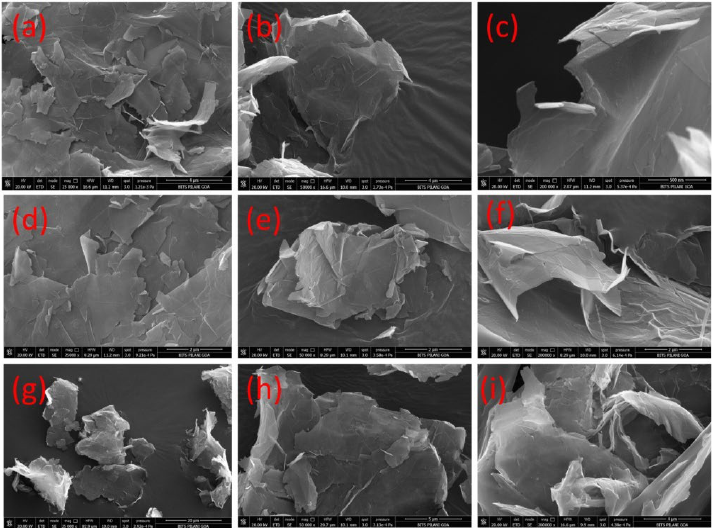
Figure 1. Captured FESEM images of graphene nanoparticles ( a – c ) H5, ( d – f ) H15 and ( g – i ) H25 at ( a , d , g ) × 25,000, ( b , e , h ) × 50,000 and ( c , f , i ) × 200,000